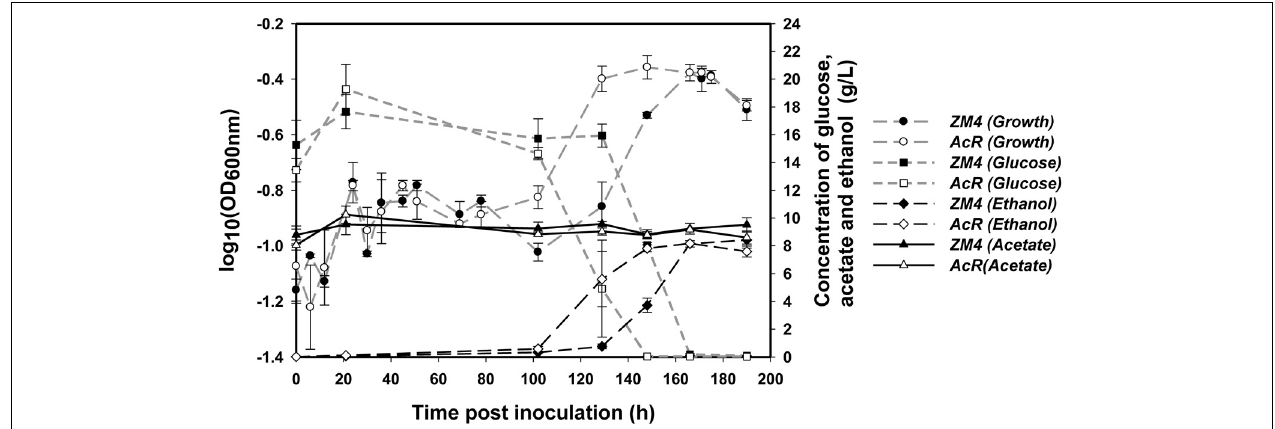
FIGURE 1 | The growth, glucose consumption, ethanol production and acetate amount of Z. mobilis wild-type ZM4 and acetate-tolerant mutant AcR in the presence of ∼ 10g/L